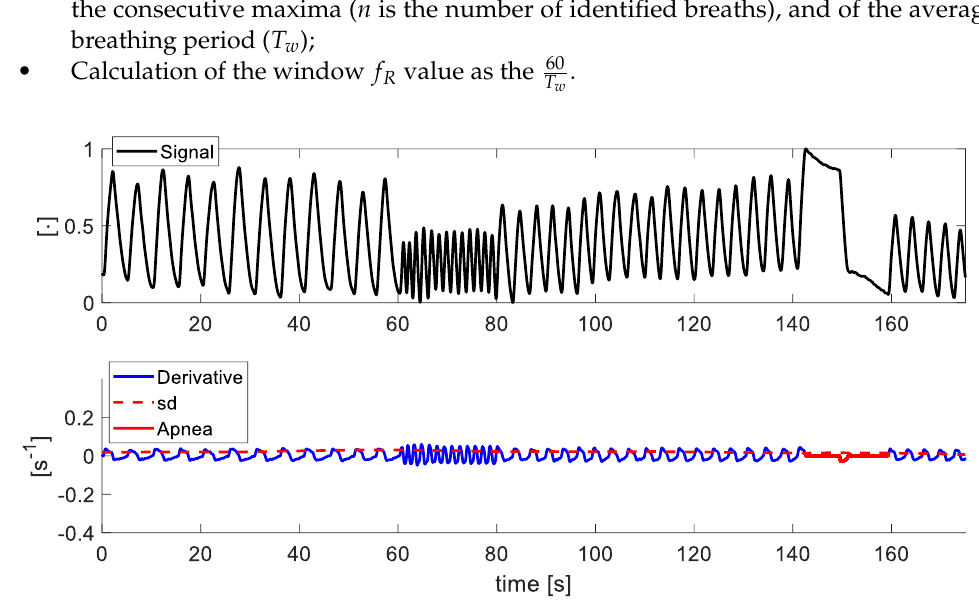
Figure 5. In the first subplot, a signal obtained by the FO method from a video without the portions of the signal identified as artefacts; in the second subplot the derivative of the signal and the sd represented as red dashed lines. In red, the apneas identified on the derivative. Table 2. Apneas detection